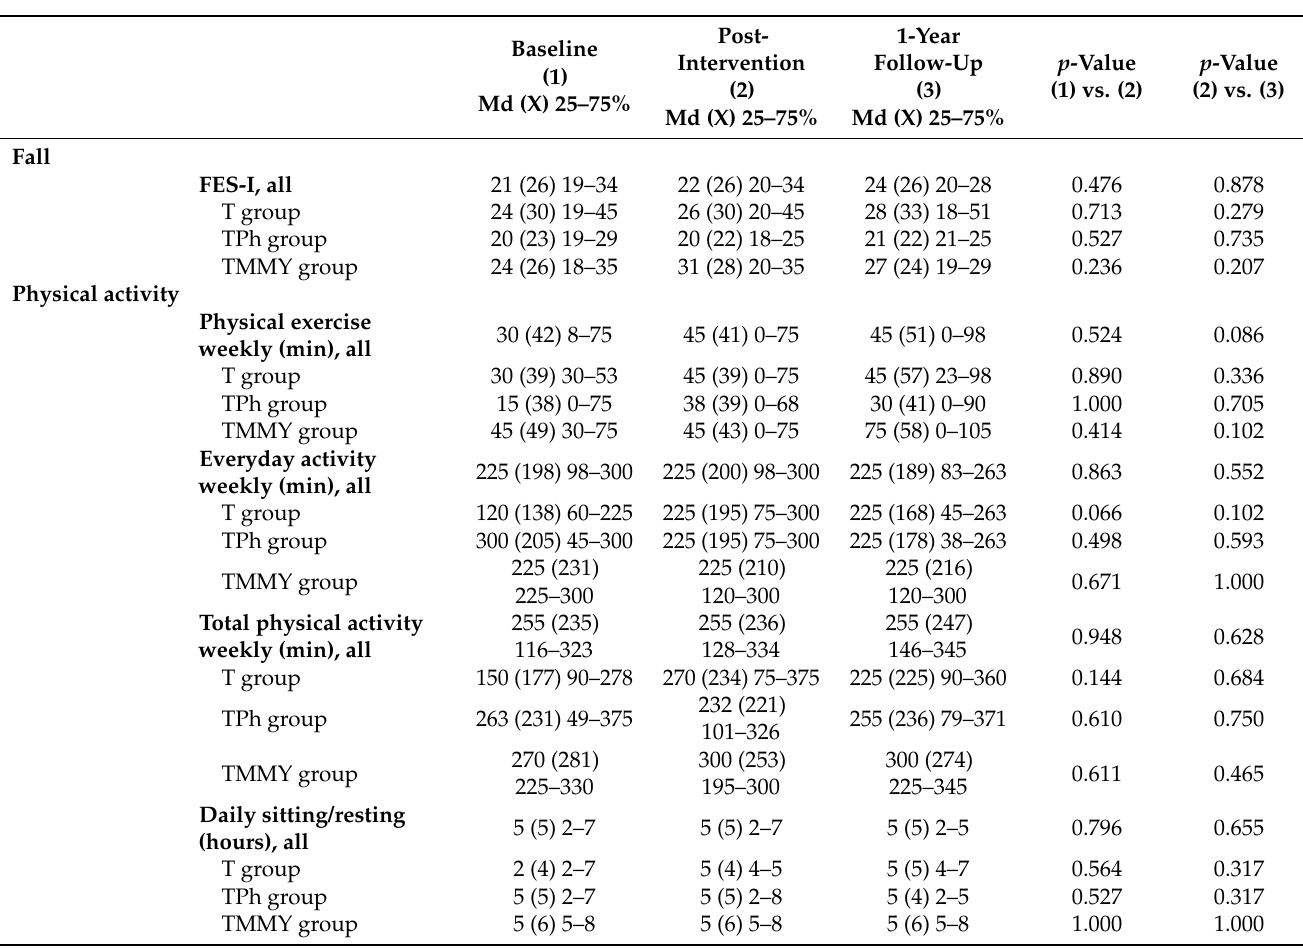
Table 5. Outcomes and the change between the baseline, post-intervention, and 1-year post- intervention